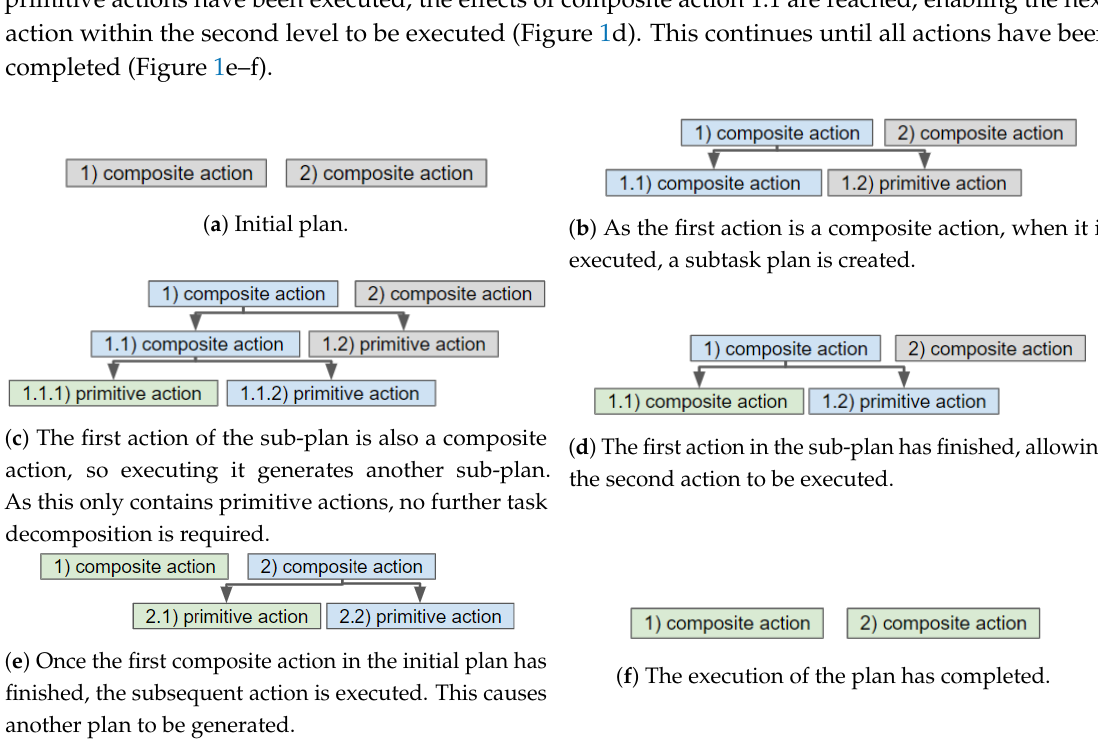
Figure 1. Grey boxes indicate actions which have not yet been executed; blue shows the actions currently being executed and green indicates executed actions. These figures describe the general concept of hierarchical planning in the now, introduced by Kaelbling and Lozano-Pérez